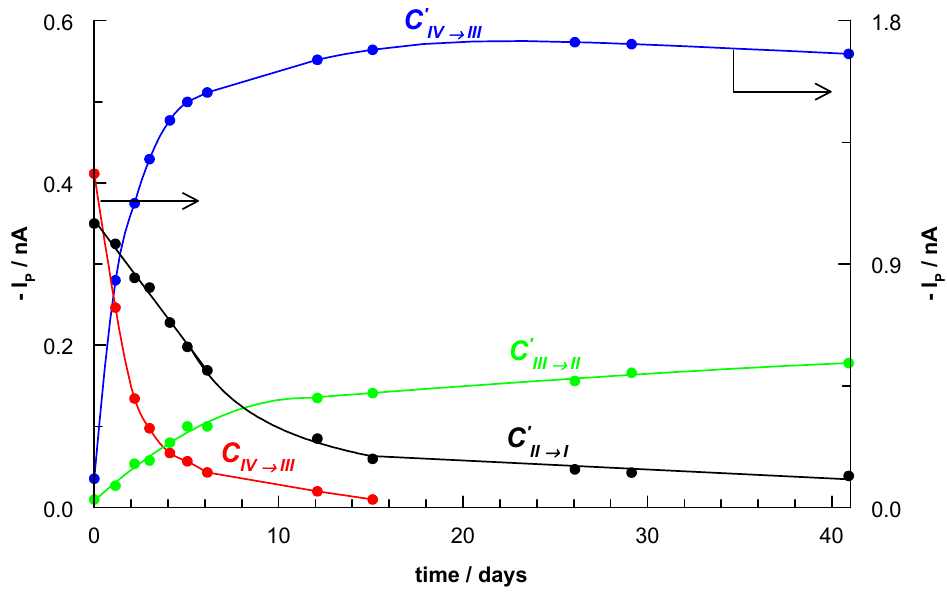
Figure 9. The changes of DPV peak currents for complex 1 over time.